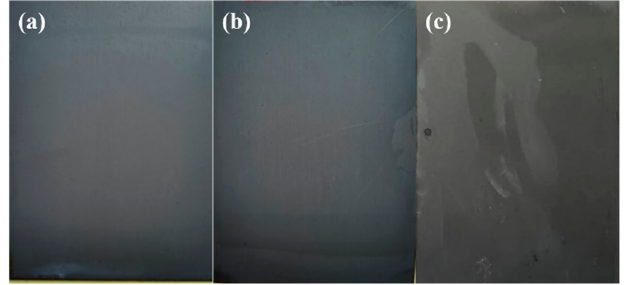
Figure 14. The morphology of sample with different coatings: ( a ) 0.5% Li-Mg, ( b ) 0.5% Li and ( c ) 0.5% Li-Mg after NSS for 24 h.